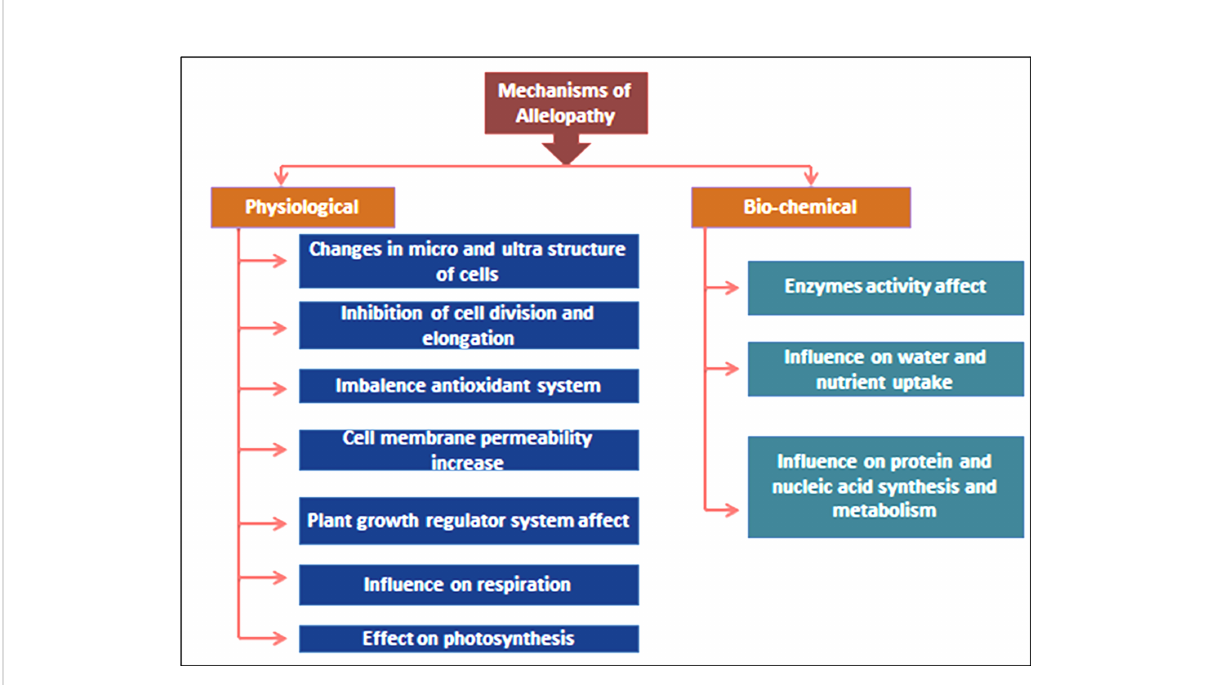
FIGURE 4 Mechanism of allelopathic effects on receiver